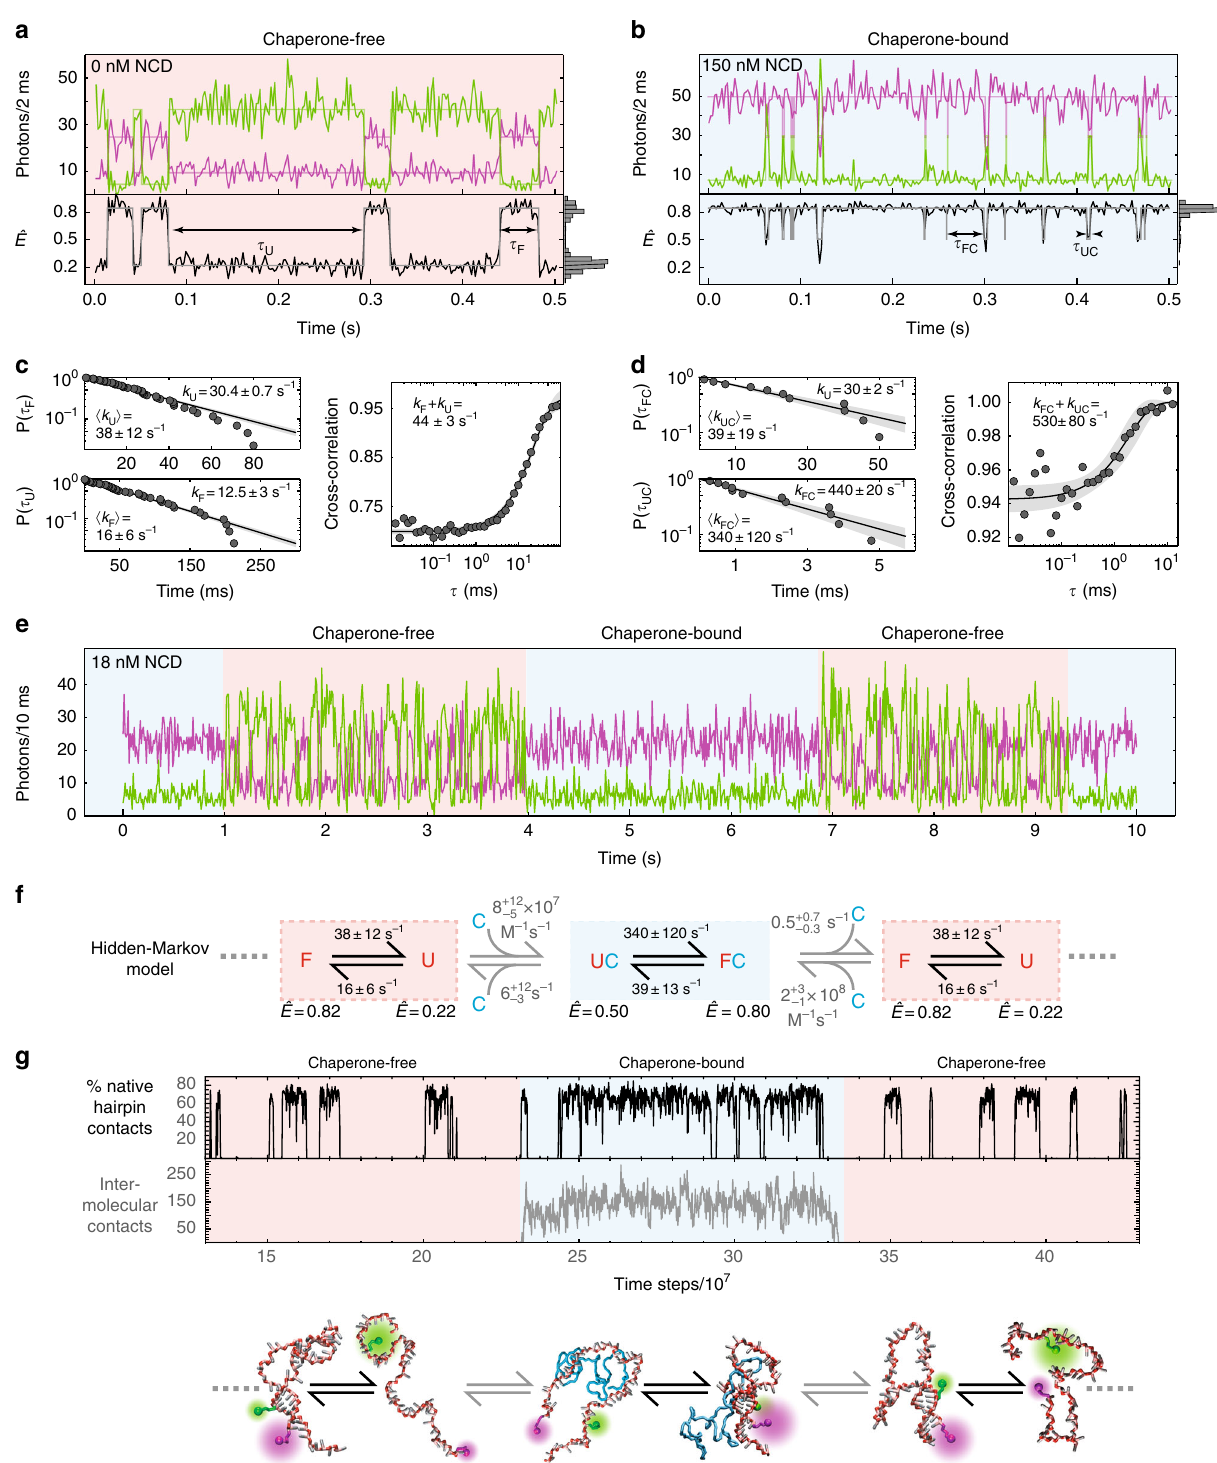
distance dynamics characteristic of intrinsically disordered pro- teins 32 – 35 , supporting the notion that NCD remains disordered while bound to nucleic acids 19 . (Fig. 3a, c). To isolate the UC complex, analogous experiments were conducted with the folding-incompetent DNA. The intramolecular transfer ef fi ciencies of NCD (S2C-S130C, S2C-